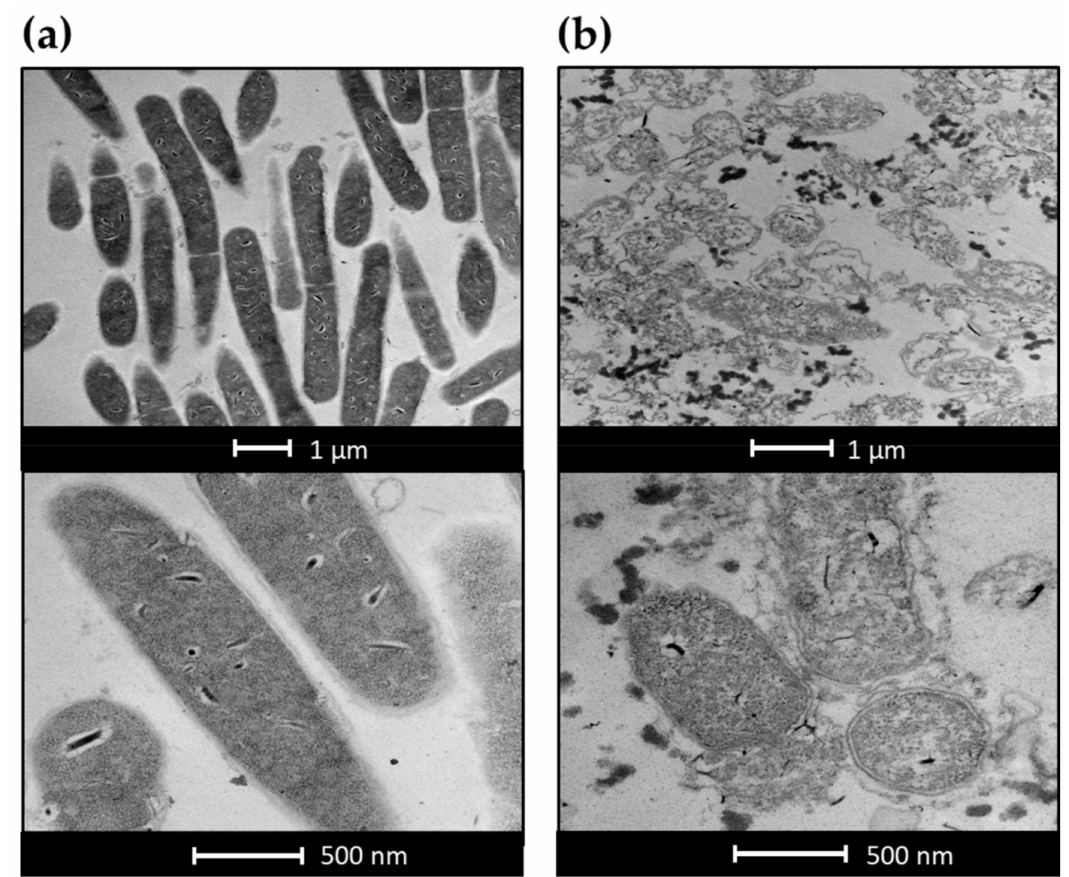
Figure 7. Transmission electron microscopy of LysB-treated C. sporogenes ATCC 7955. ( a ) Untreated C. sporogenes cells, ( b ) C. sporogenes treated with 50 µ g/mL LysB for 20